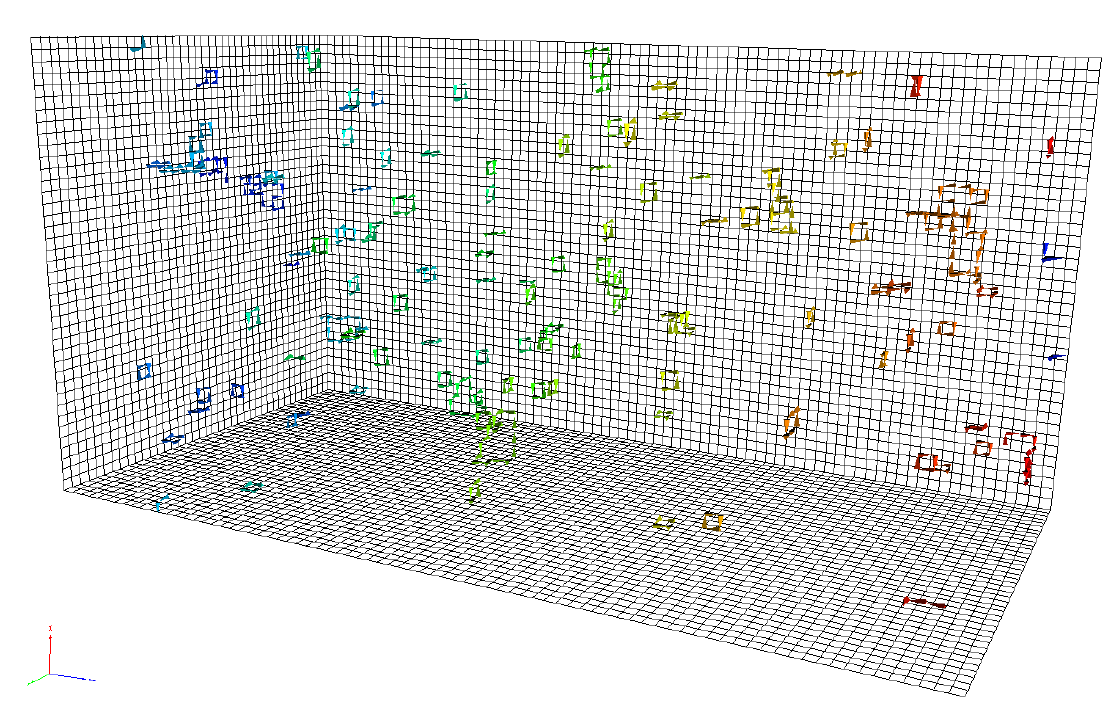
Figure 5: The centre-vortex structure of secondary loops in a ground-state vac- uum field configuration of dynamical 2 + 1 flavour QCD. ( Click to activate. ) The flow of + 1 centre charge in the secondary loops is